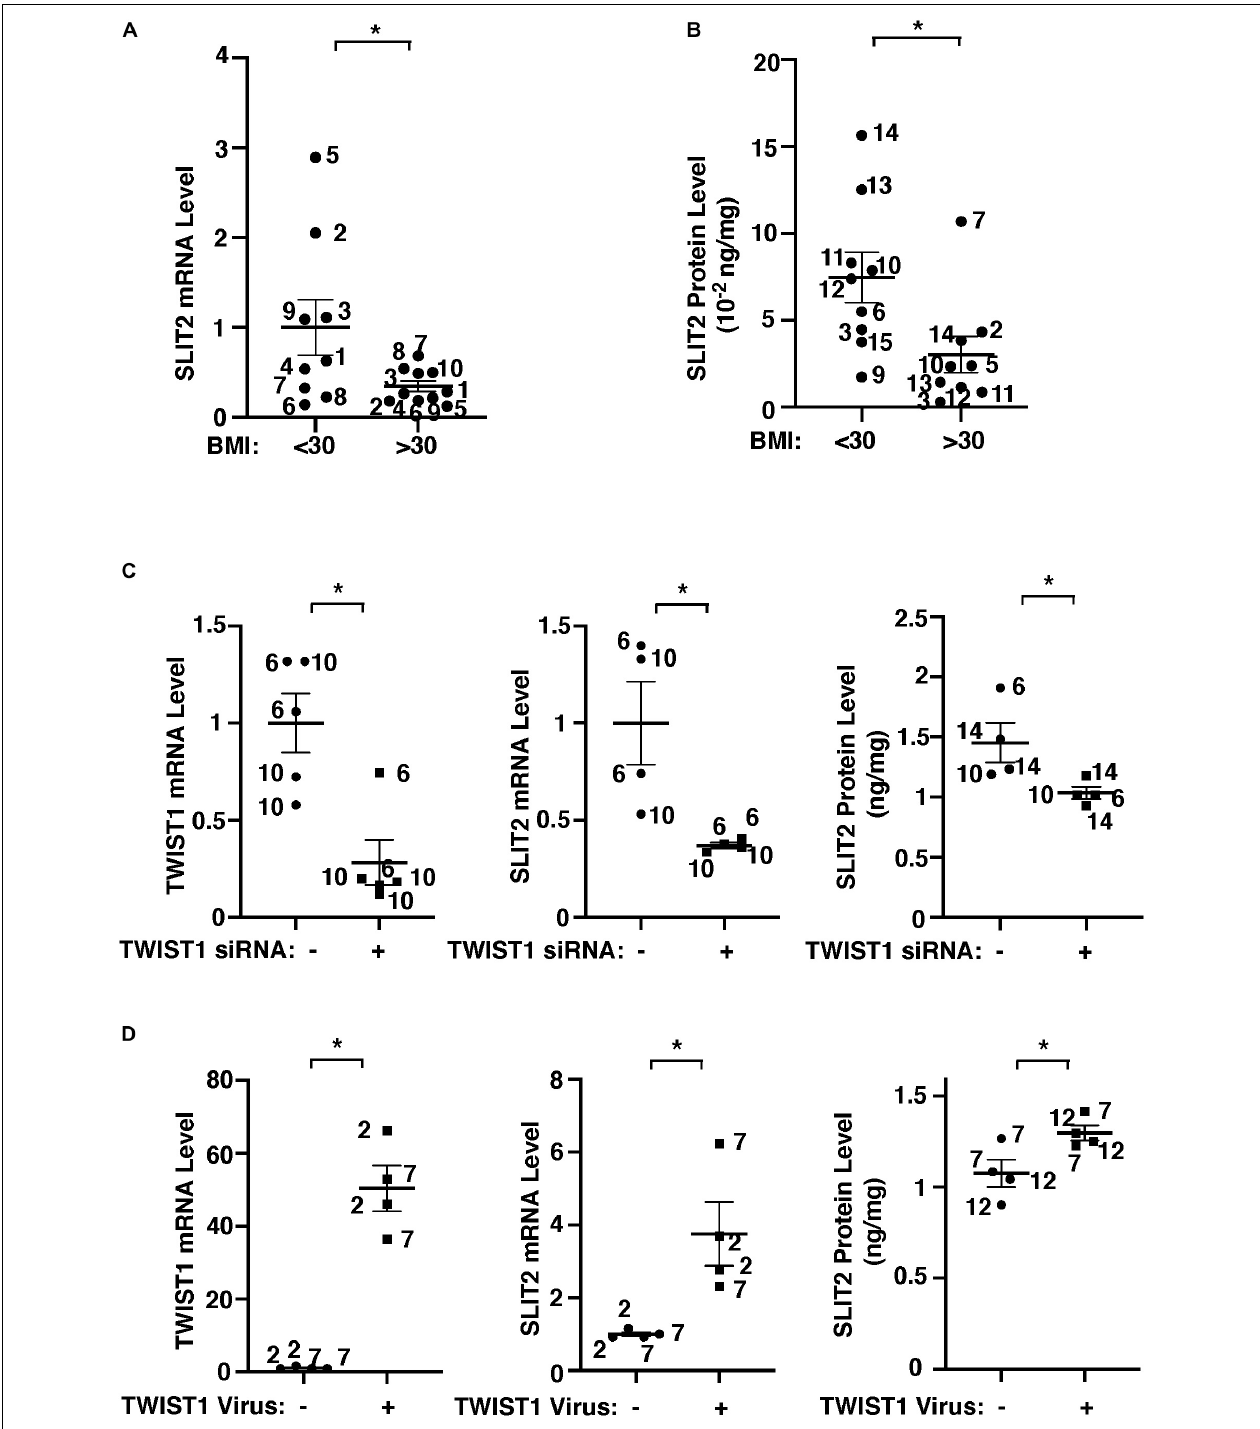
FIGURE 2 | TWIST1 controls SLIT2 expression in lean vs. obese adipose ECs. (A) Graph showing SLIT2 mRNA expression in lean vs. obese human adipose ECs ( n = 9–10, mean ± SEM, * p < 0.05). (B) Graph showing SLIT2 protein expression in lean vs. obese human adipose tissues ( n = 9, mean ± SEM, * p < 0.05). (C) Graphs showing mRNA expression of TWIST1 and SLIT2 in lean human adipose ECs treated with TWIST1 siRNA or control siRNA with irrelevant sequences ( n = 4–5, mean ± SEM, * p < 0.05). Graph showing protein expression of SLIT2 in lean human adipose ECs treated with TWIST1 siRNA or control siRNA with irrelevant sequences ( n = 4, mean ± SEM, * p < 0.05). (D) Graphs showing mRNA expression of TWIST1 and SLIT2 in obese human adipose ECs treated with lentivirus overexpressing TWIST1 or control virus ( n = 4, mean ± SEM, * p < 0.05). Graph showing protein expression of SLIT2 in obese human adipose ECs treated with lentivirus overexpressing TWIST1 or control virus ( n = 4, mean ± SEM, * p < 0.05). The numbers along the dots correspond to the clone numbers in Table 1 .